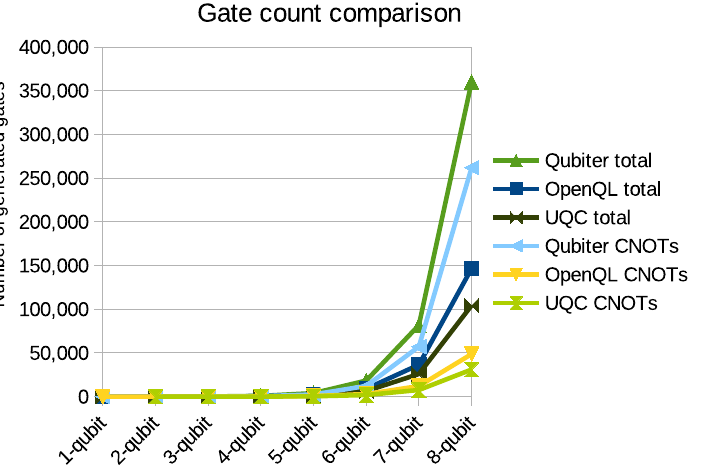
Figure 15. Number of generated CNOTs and total gates for OpenQL, UQC and Qubiter from the decomposition of different sizes of unitary matrices.